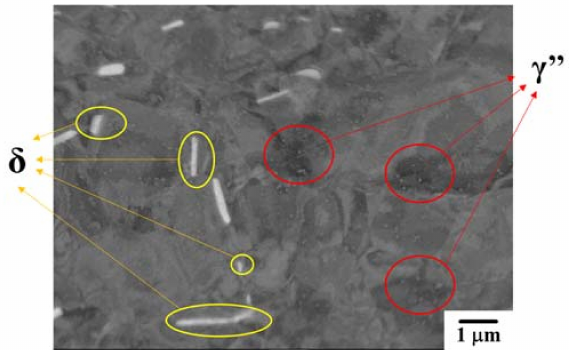
Figure 12. Microstructure with precipitated δ and γ ” phases in superalloy 718 after hot compression